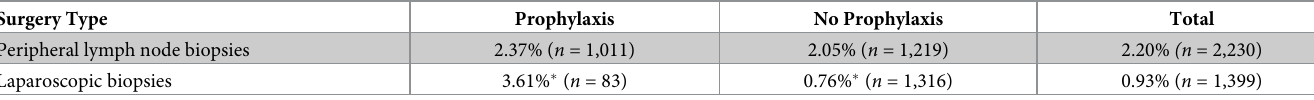
Table 2. Surgical complication rates: Prophylactic vs no prophylactic antibiotics.